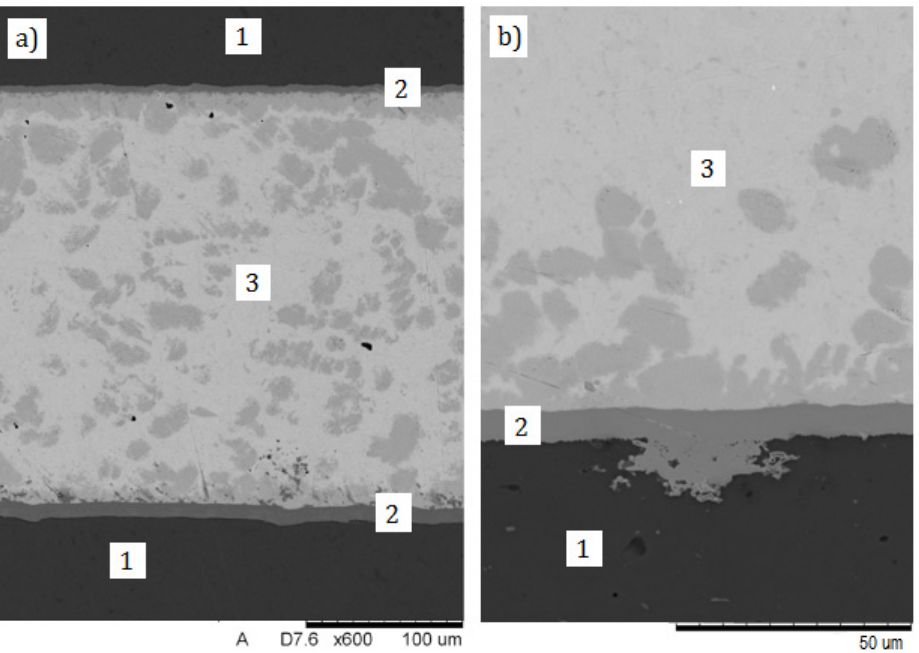
Figure 7. Microstructure of soldered joint made via Ni-P interlayer ( a ), filled surface defects of the substrate ( b ): 1—substrate (aluminum 7075), 2—Ni-P interlayer, 3—solder.